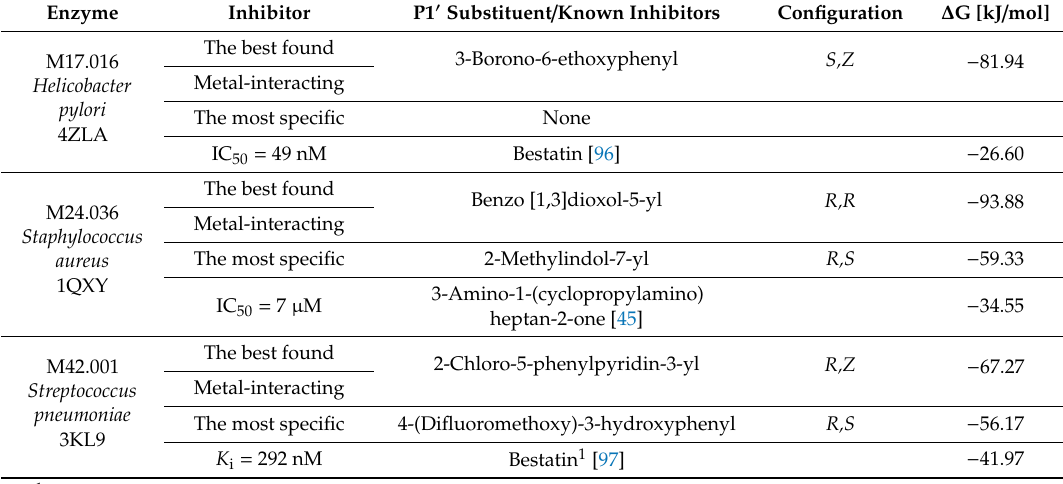
Table 7. Selected bacterial metallo-aminopeptidases with P1 (cid:48) substituents that were the most favored, had the best interaction with the catalytic metal ion via the phosphinate group, and were the most specific are shown. The stereochemistry of the ligands and the calculated Gibbs free energy of binding in the active center are included. Known inhibitors are given as